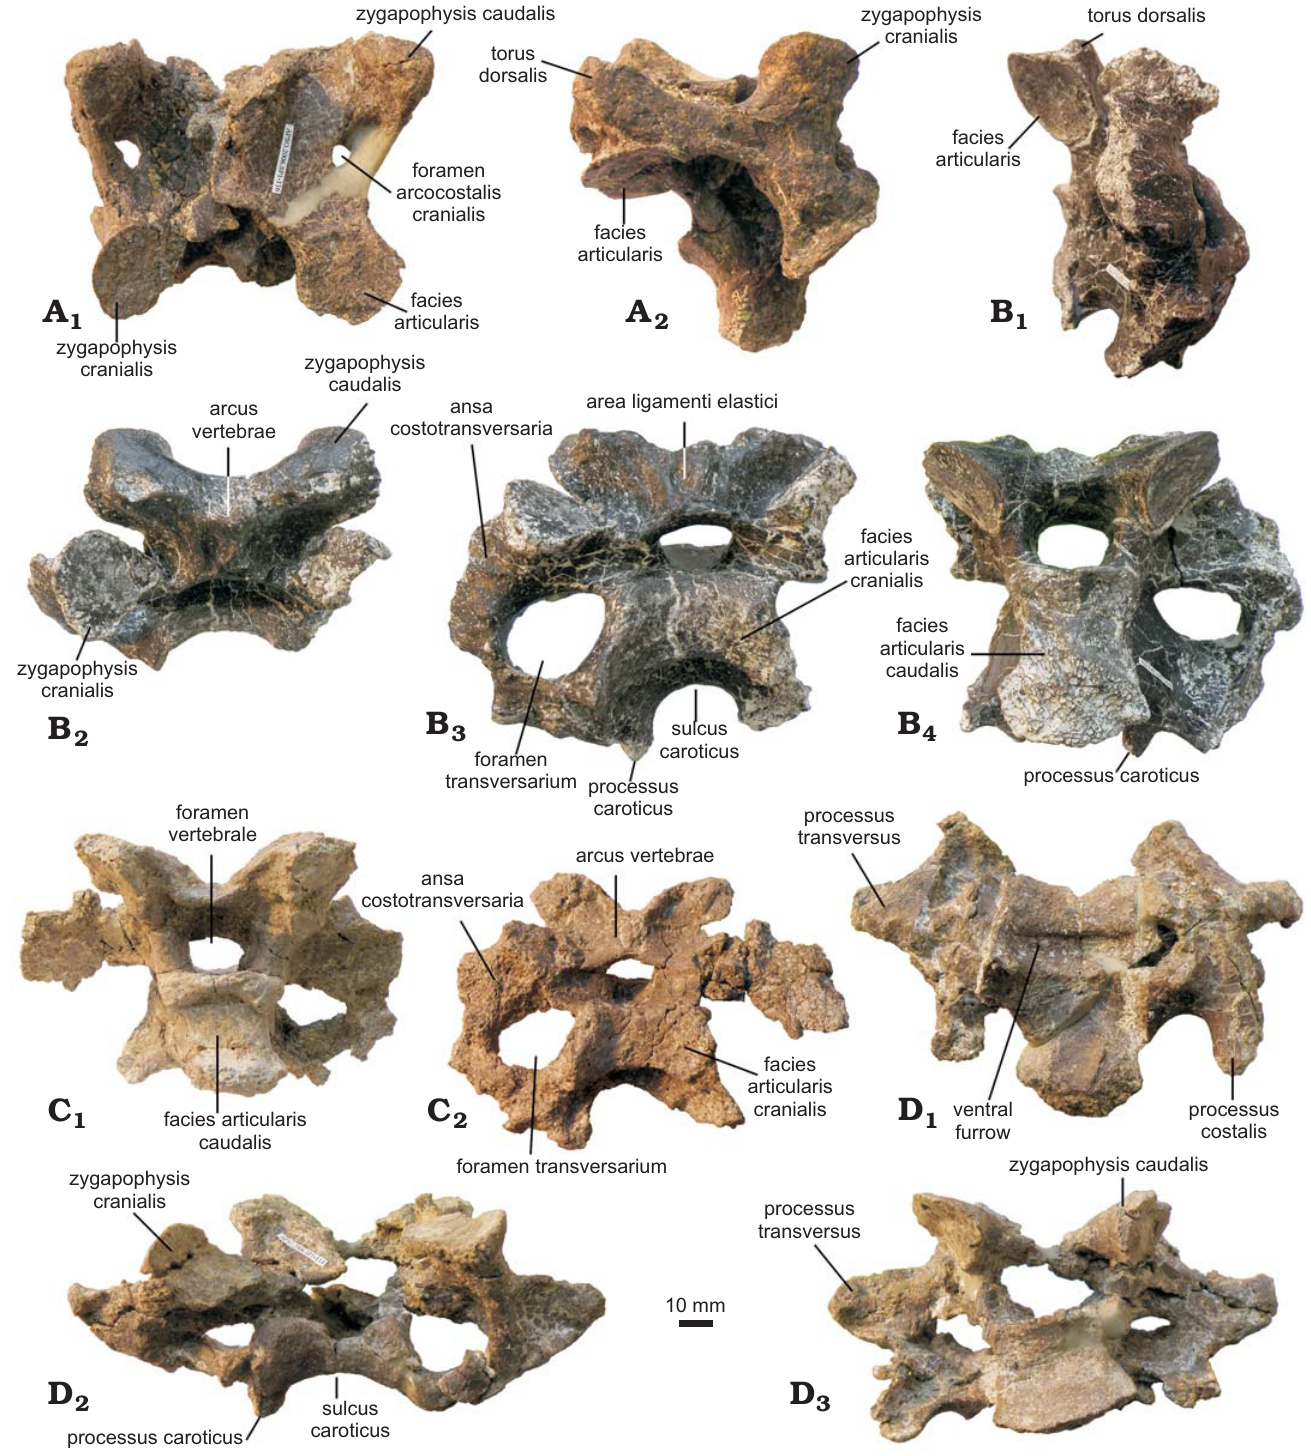
Fig. 3. Vertebrae cervicales of gastornithid bird Gastornis parisiensis Hébert, 1855, early Eocene, La Borie, France. A . MHNT.PAL.2013.15.6, in dorsal (A ) and right lateral (A ) views. B . MHNT.PAL.2013.15.7, in right lateral (B 1 2 in caudal (C ) and cranial (C ) views. D . MHNT.PAL.2013.15.5, in ventral (D 1 2